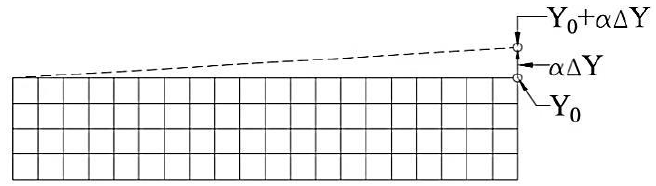
Figure 5. Description of shape design